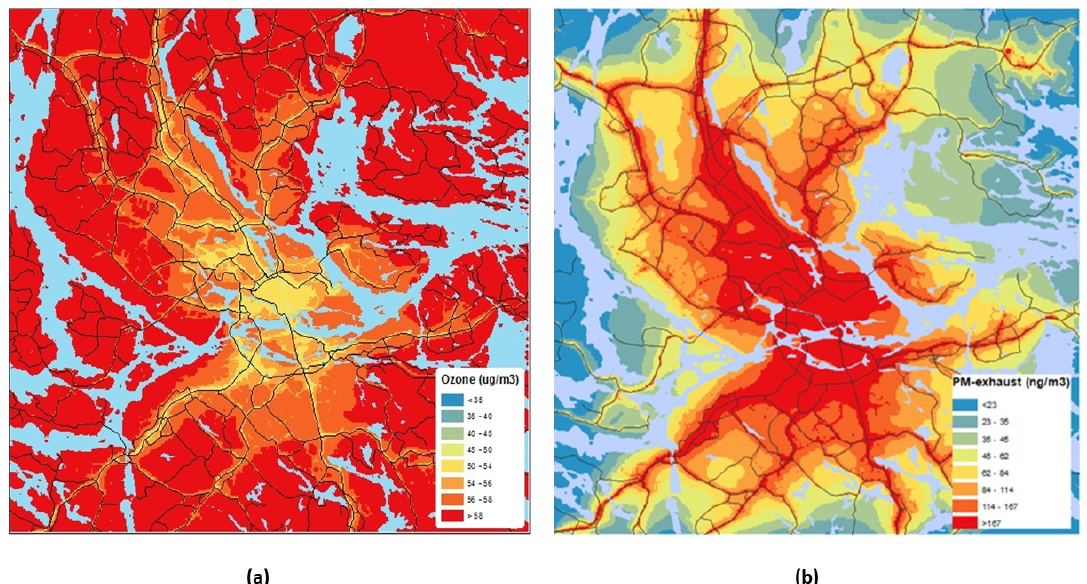
Figure 2. Spatial distribution of ozone ( a ) and exhaust particles ( b ) concentrations in the model domain encompassing all mothers. The concentrations were calculated at a resolution of 100 × 100 m and the figures show the averages of all hours during the whole period, 2003 − 2013.